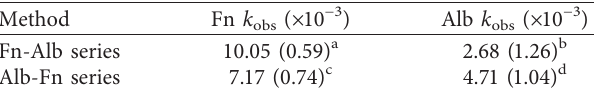
Values in brackets are SD. Different superscript letters indicate a significant difference ( P < 0 .